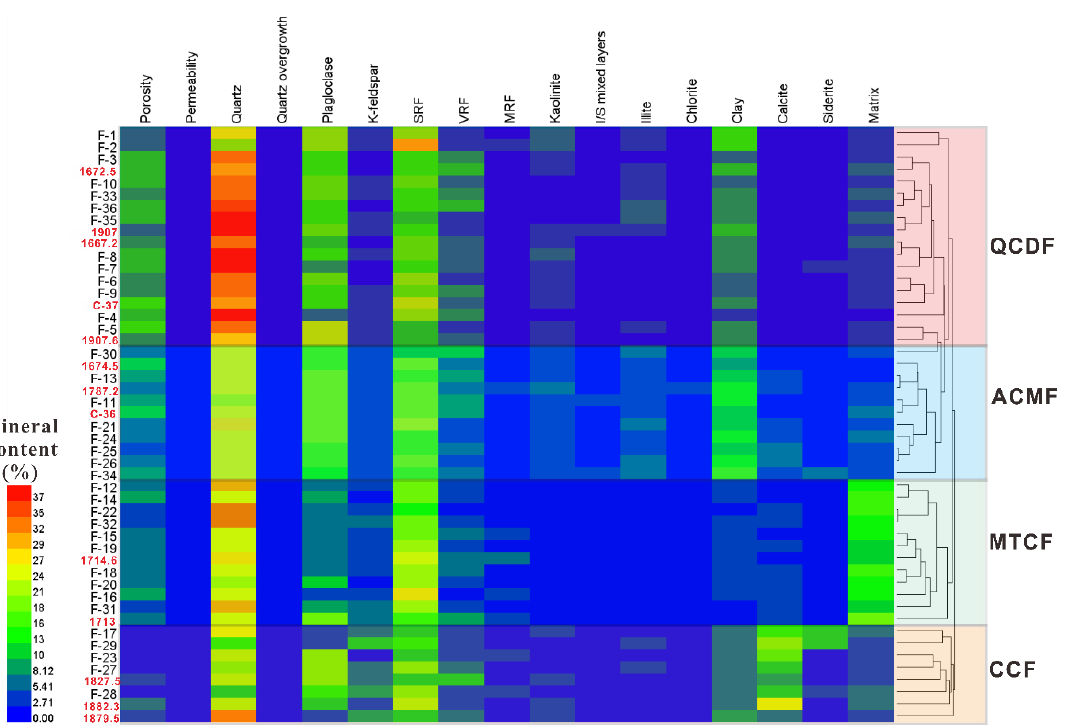
Figure A1. The clustering heatmap of petrophysical properties and mineral contents which is employed to choose the representative samples of four lithofacies for characterizing pore structures of the tight sandstones in J 1 b.